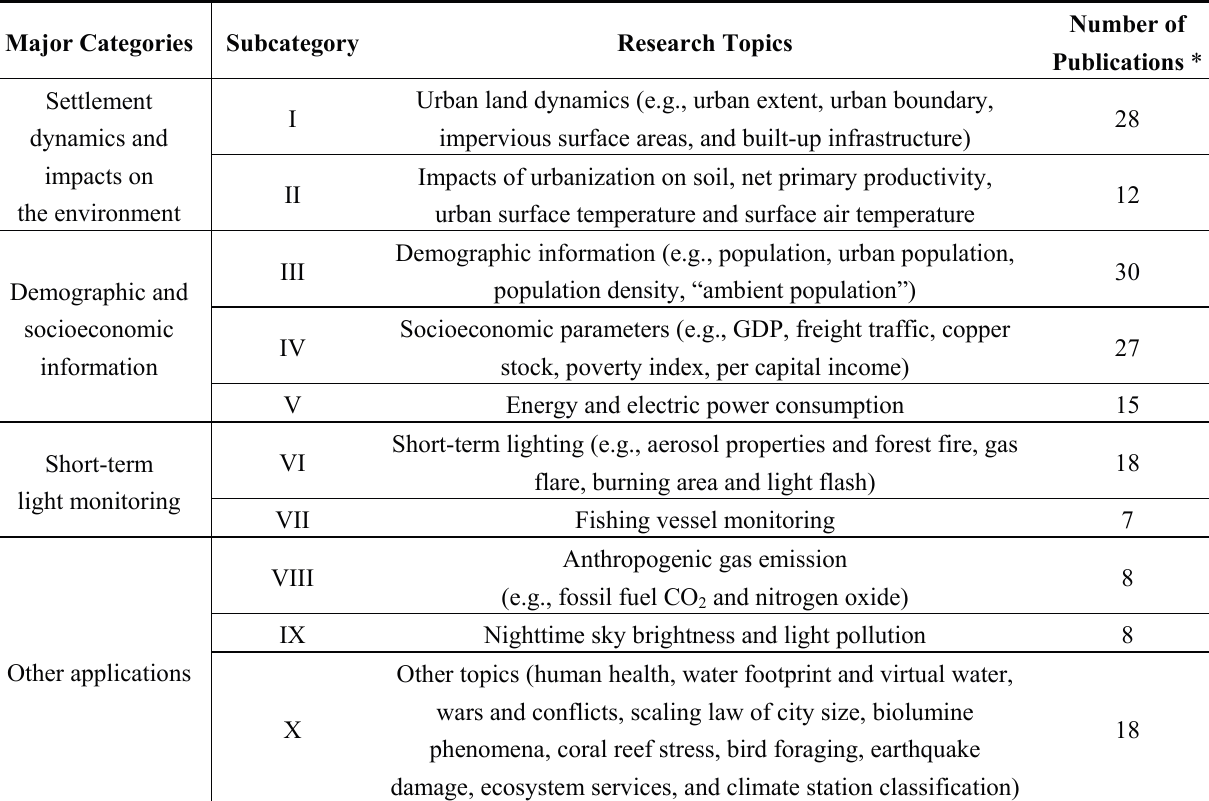
Table 6. Applications of DMSP/OLS nighttime images for different research